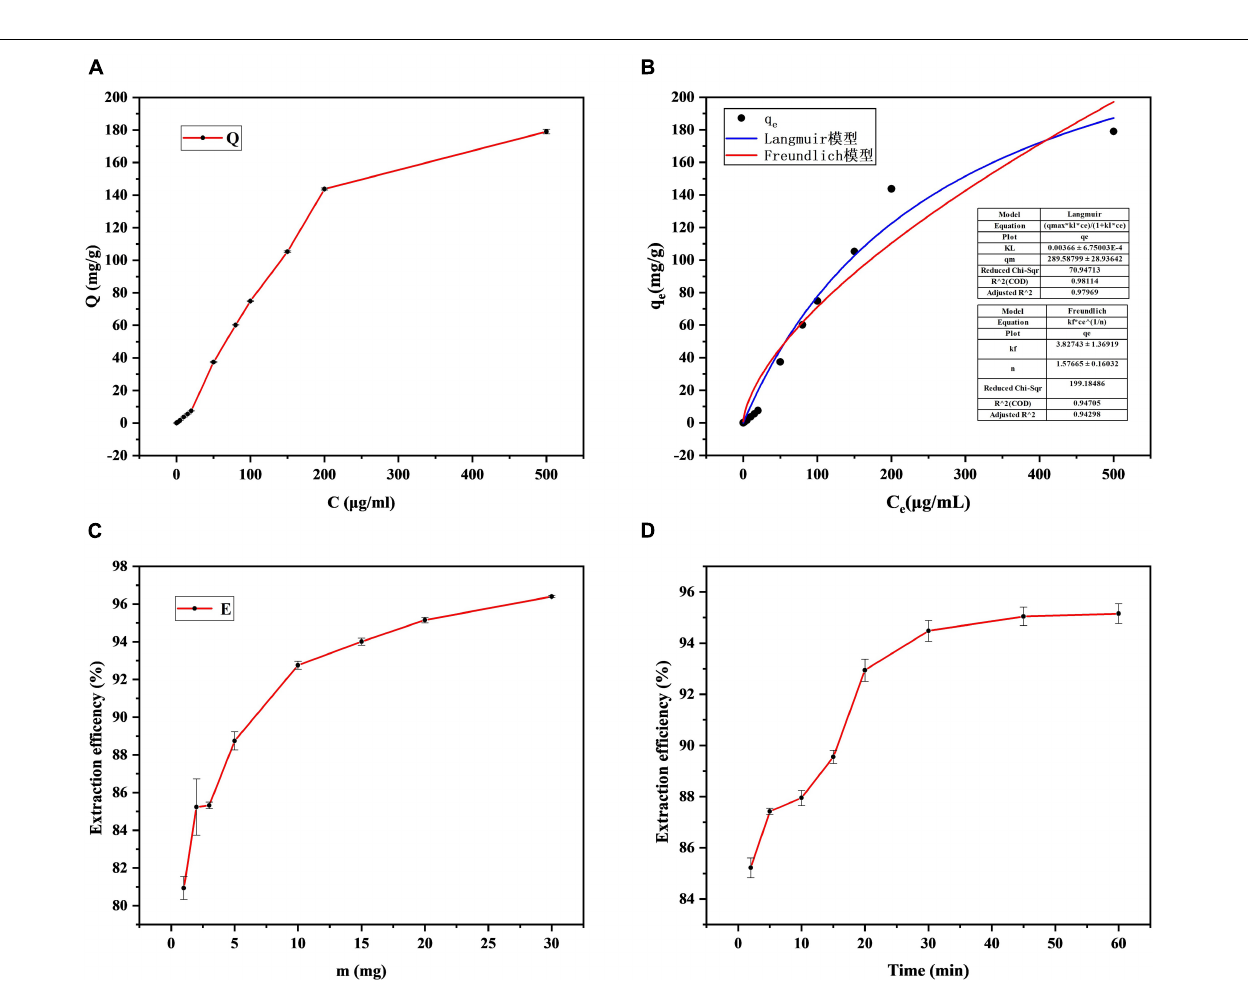
Frontiers in Nutrition |